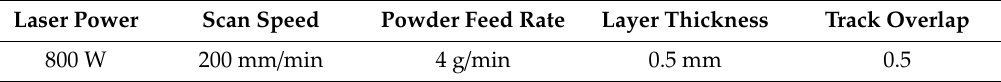
Table 4. Directed Energy Deposition (DED) processing parameters for repair.